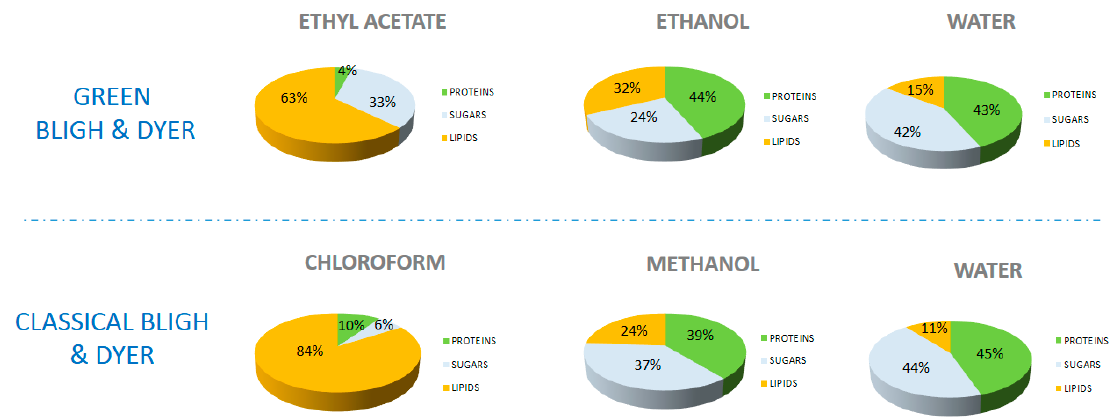
Figure 1. Initial test of solubilities in pure solvents. Relative distribution (weight) of different extracted compounds (lipids, proteins and sugars) in the pure solvents.